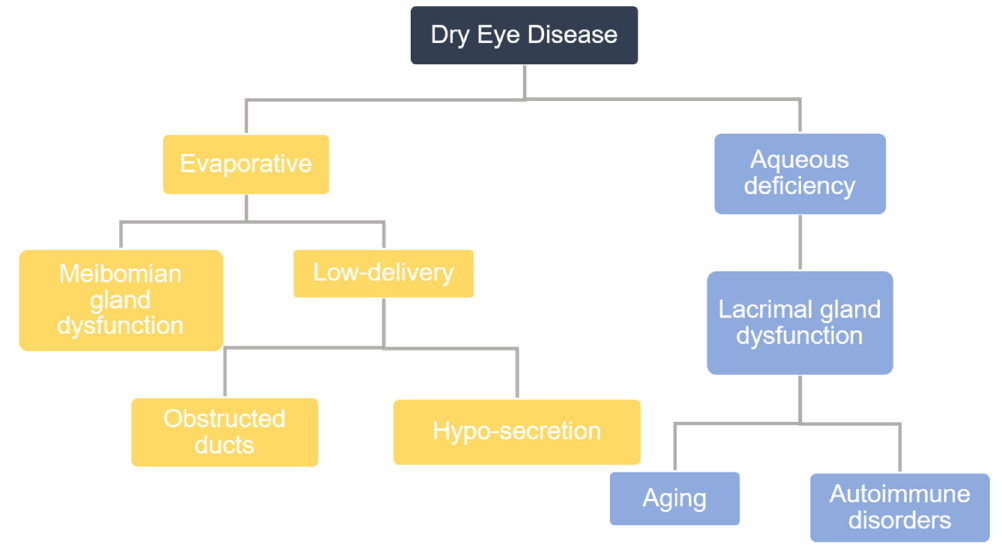
Figure 1. A flowchart representation of the categorization of dry eye disease (DED) according to